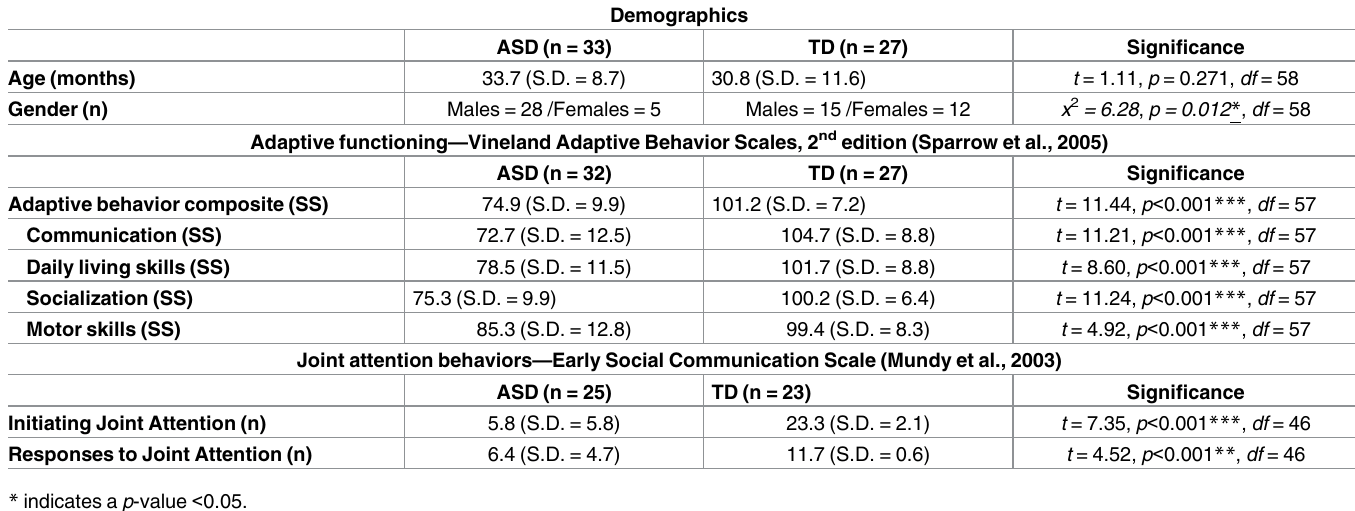
Table 1. Demographics, adaptive functioning and featuresof joint attention behavior in the ASD and TD